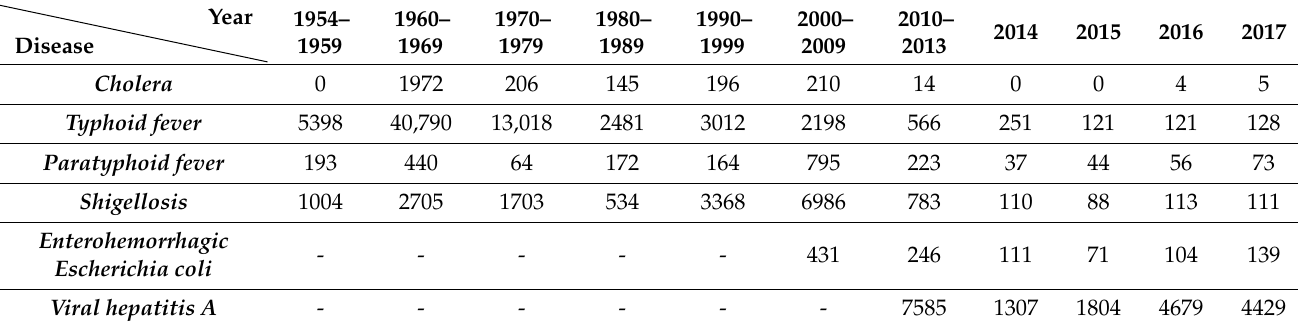
Disease Table 1. Prevalence of National Notifiable Infectious Category I Diseases in Korea (restructured based on [12,13]).